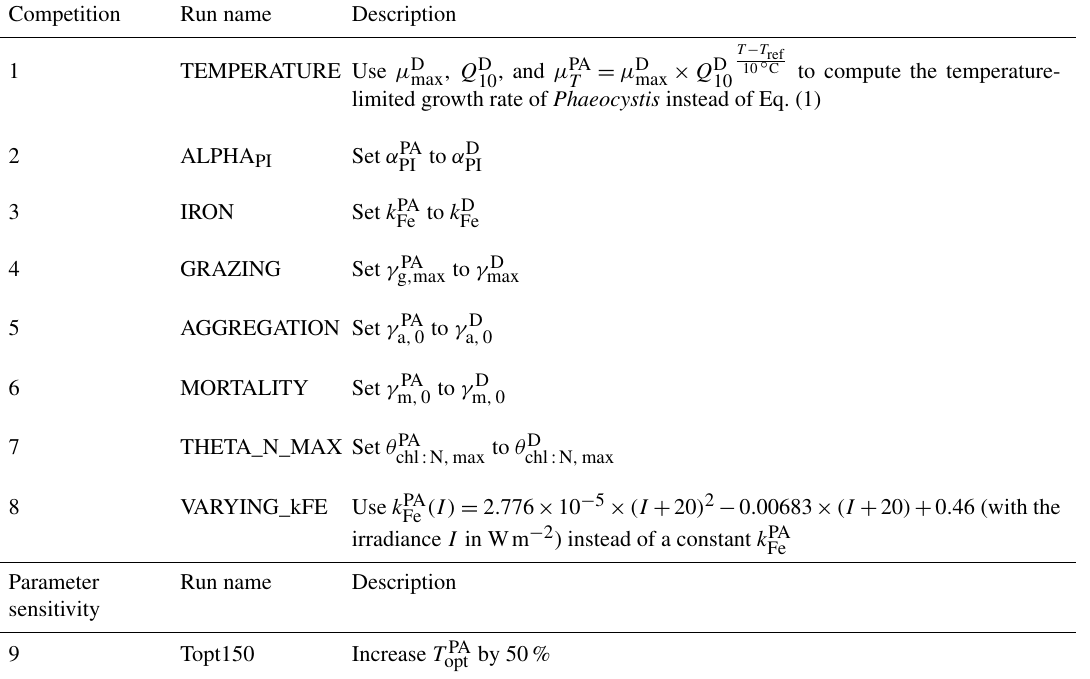
Table 2. Overview of sensitivity experiments aiming to (1) assess the sensitivity of the simulated Phaeocystis –diatom competition to chosen parameter values and parameterizations of Phaeocystis (competition experiments, runs 1–8) and (2) assess the sensitivity of the simulated biomass distributions to chosen Phaeocystis parameter values (parameter sensitivity experiments, runs 9–22). The results of the parameter sensitivity experiments are discussed in the Supplement. See Table 1 and Sect. 2.1 for parameter values and parameterizations of Phaeocystis in the reference simulation. PA is Phaeocystis , and D is